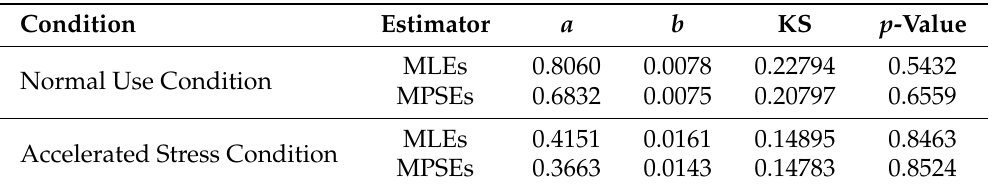
Table 5. The MLEs, MPSEs and K-S statistics with the associated p-values for the oil breakdown, assuming complete